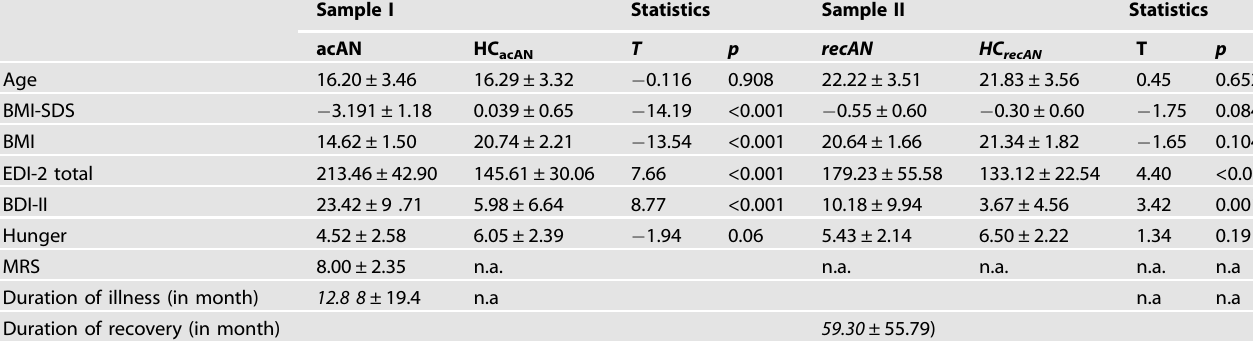
Table 1. Means and standard deviations for demographic and clinical